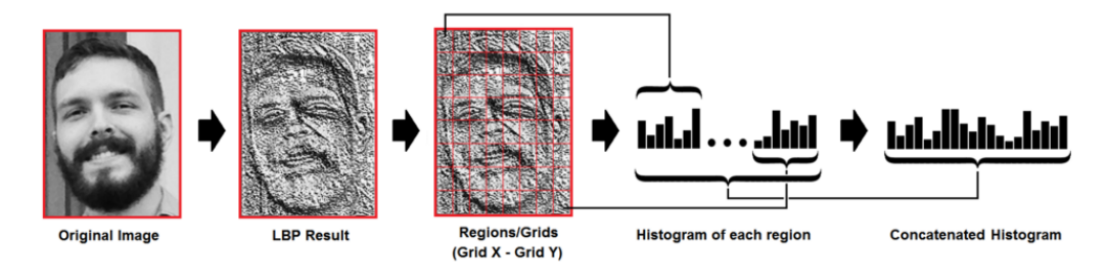
Figure 2. Sample example of regions/grids on image